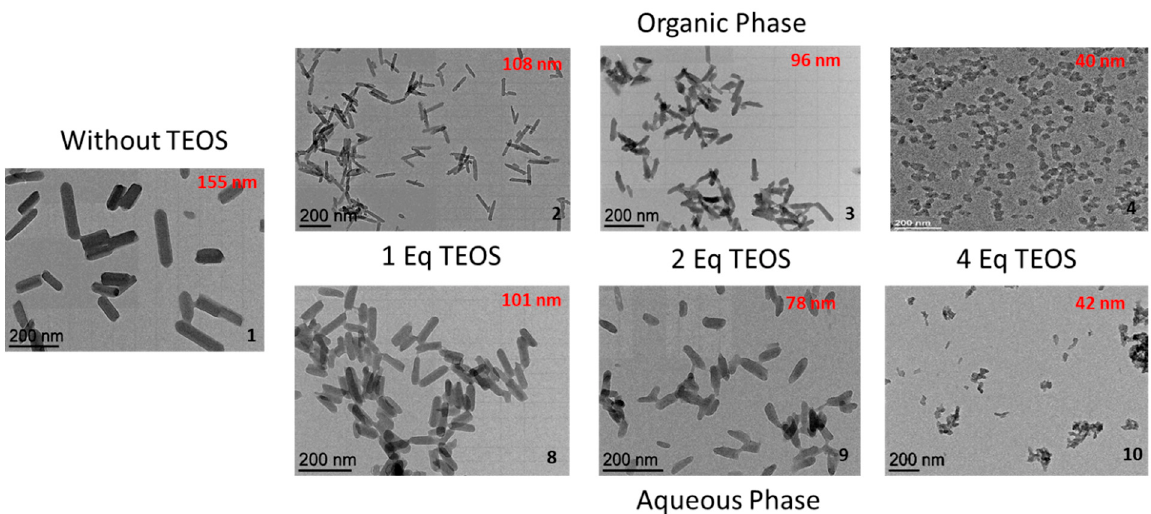
Figure 1. TEM images of the [Fe(Htrz) 2 (trz)](BF 4 )@SiO 2 nanoparticles obtained without (reference sample) and with various quantity of TEOS. TEOS is inserted either in the organic phase (synthetic route A, 2–4) or in the aqueous phase (synthetic route B, 8–10). The mean value of the length of nanoparticles is given. Thermogravimetric analysis revealed different water amounts ranging from 0.1 to 1.2 versus iron atom (Figure S1). Using this quantity of water and thanks to the various